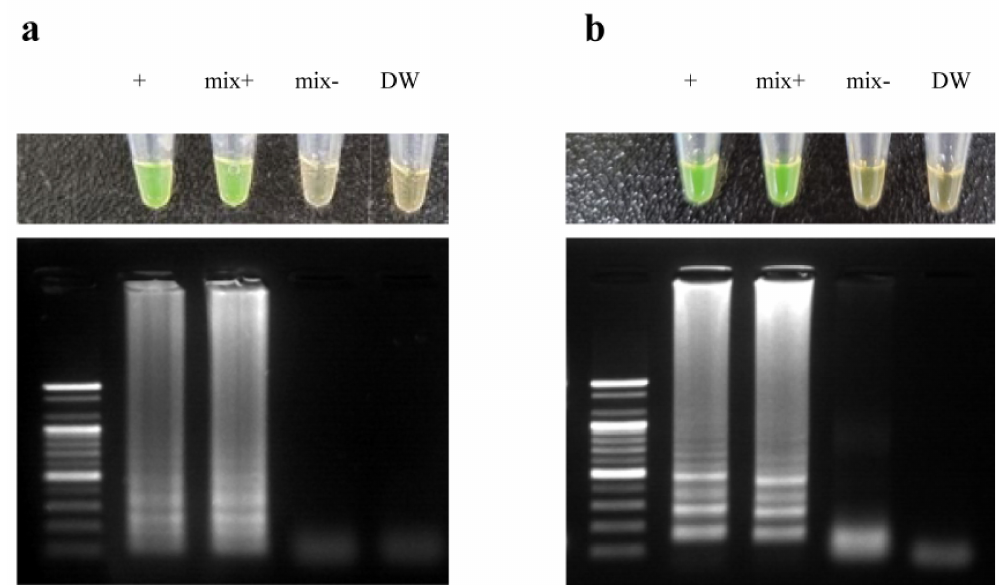
Figure 5. Species-specificity of loop-mediated isothermal amplification (LAMP) primers. LAMP reactions were performed by visual inspection with diluted SYBR Green I and electrophoresis with EtBr. ( a ) Ostreopsis cf. ovata. ( b ) Amphidinium massartii .